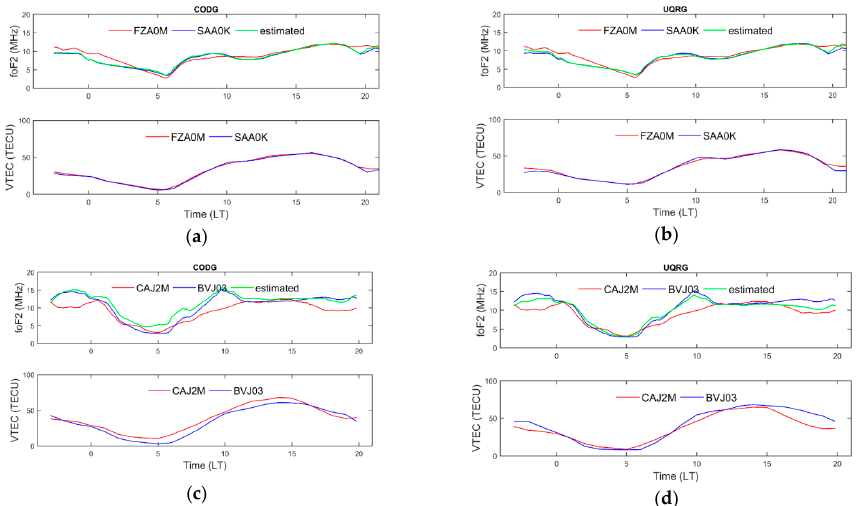
Figure 5. Comparison of fo F 2 measured with ionosondes and the values estimated with GIMs versus VTEC values for the respective ionosondes using CODG ( a , c ) and UQRG ( b , d ). Remote Sens. 2020 , 12 , x FOR PEER REVIEW